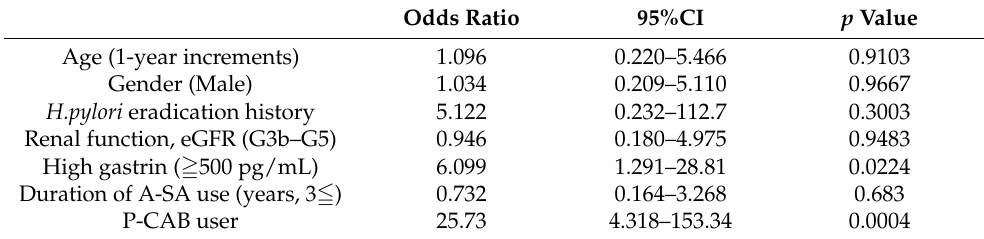
Figure 4. Comparison of the fasting serum gastrin level between patients with and without each PPI-related gastric lesion: * p < 0.05; ** p < 0.01; Wilcoxon rank-sum test; PPI, proton pump inhibitor; FGP, fundic gland polyps; GCSM, gastric cobblestone-like mucosa; WS, white spot. factors of WS prevalence with an odds ratio of 6.099 ( p = 0.0224) and 25.73 ( p = 0.0004), respectively. Table 4. Multivariate analysis of WS